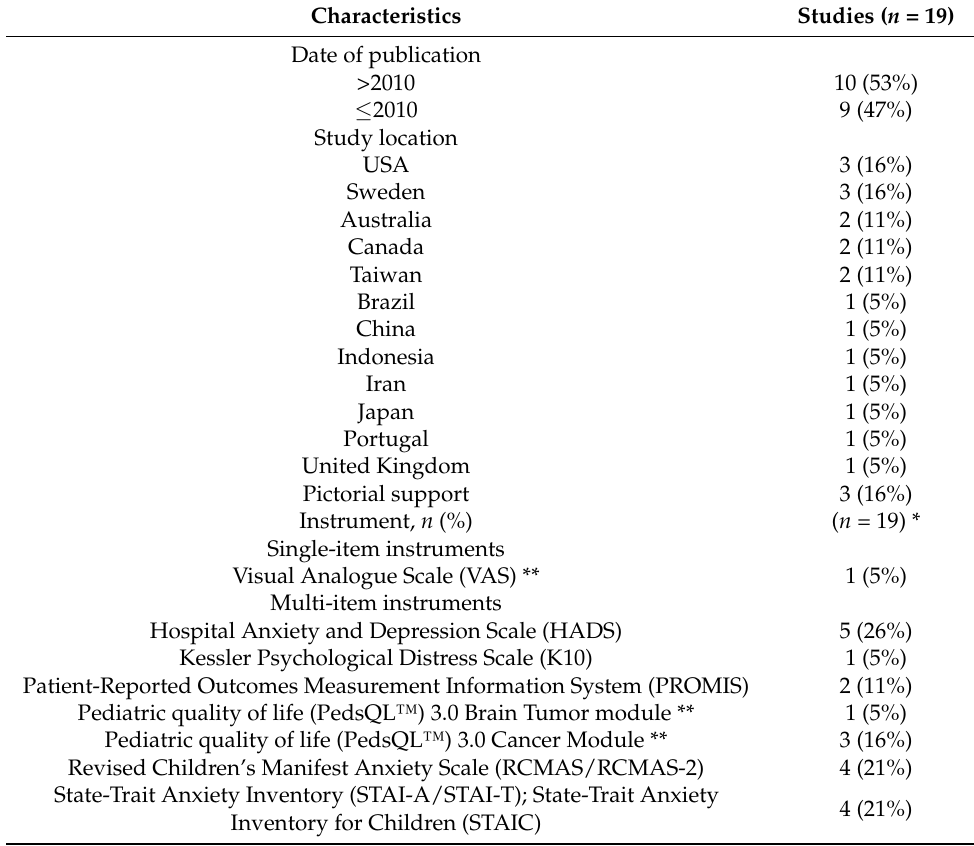
Table 3. Summary of the study